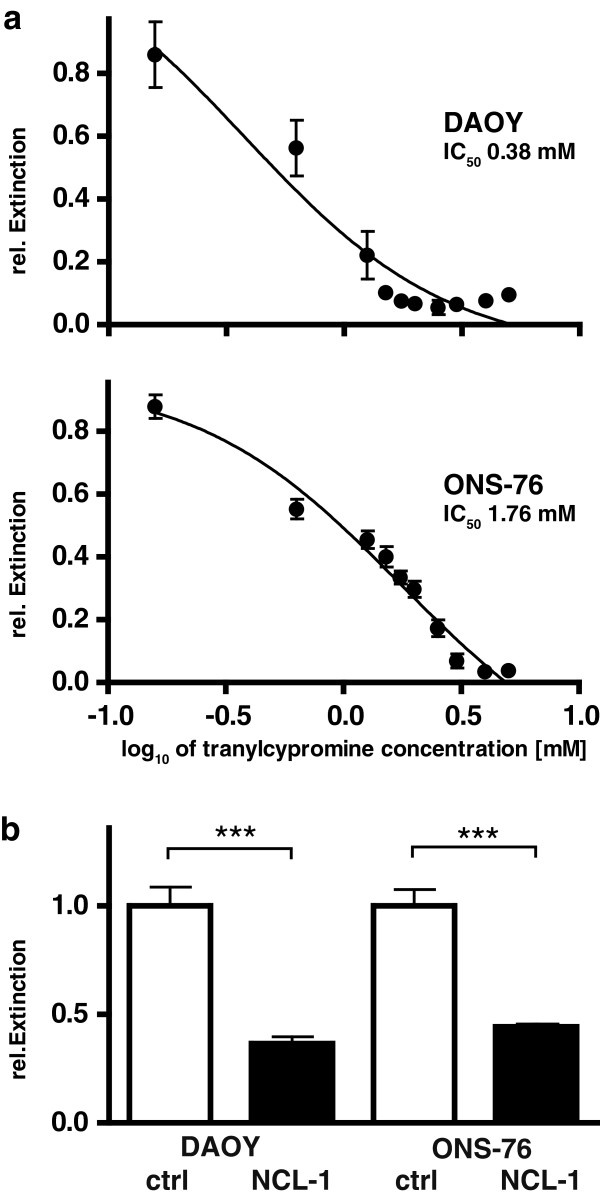
Inhibiting KDM1A using small molecules, tranylcypromine or NCL-1, effectively suppressed medulloblastoma cell growth in vitro. a The DAOY and ONS-76 medulloblastoma cell lines were treated with the indicated concentrations of the monoaminoxidase inhibitor, tranylcypromine, and cell viability was measured by the MTT assay. Extinction relative to solvent-treated cultures at 72 h is shown for the mean of 4 experiments conducted in triplicate. b The medulloblastoma cell lines, DAOY and ONS-76 were treated 72 h with 10 μM of the KDM1A-selective inhibitor, NCL-1, or with solvent, then cell viability was measured in MTT assays. Bars represent the means of 3 independent experiments conducted in triplicate. ***p < 0.0001.